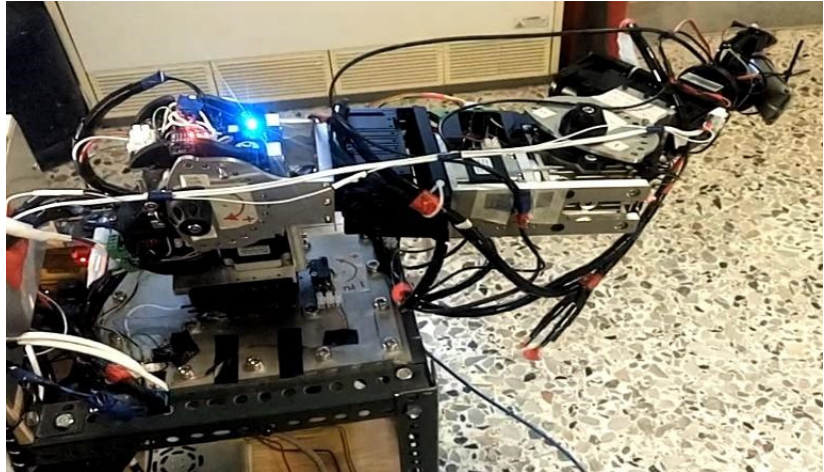
Figure 13. Optimal anatomy of the metamorphic manipulator derived under the MVR measure for Task 1.